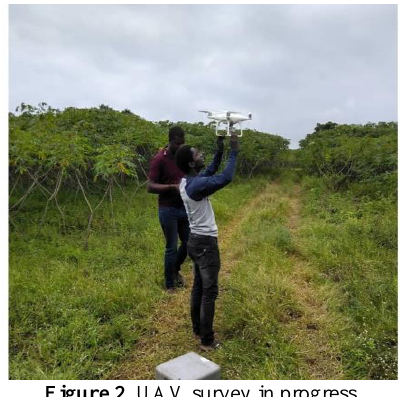
Figure 2. UAV survey in progress